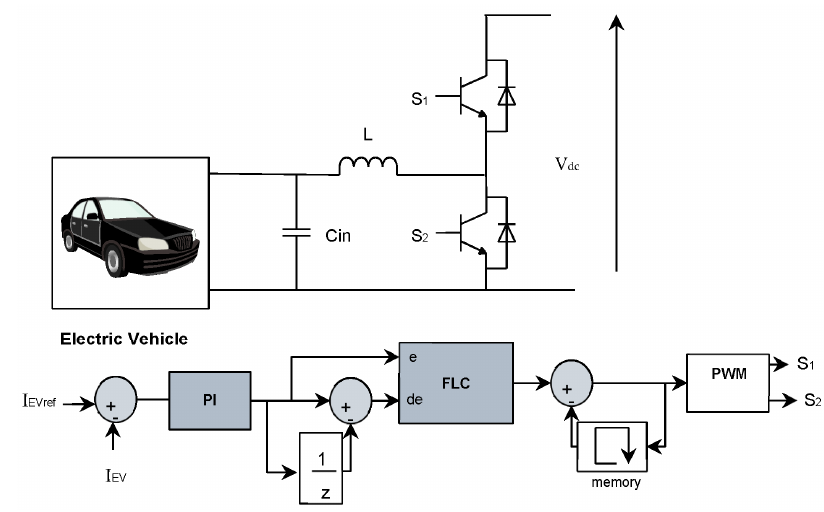
Figure 4. EV control design.